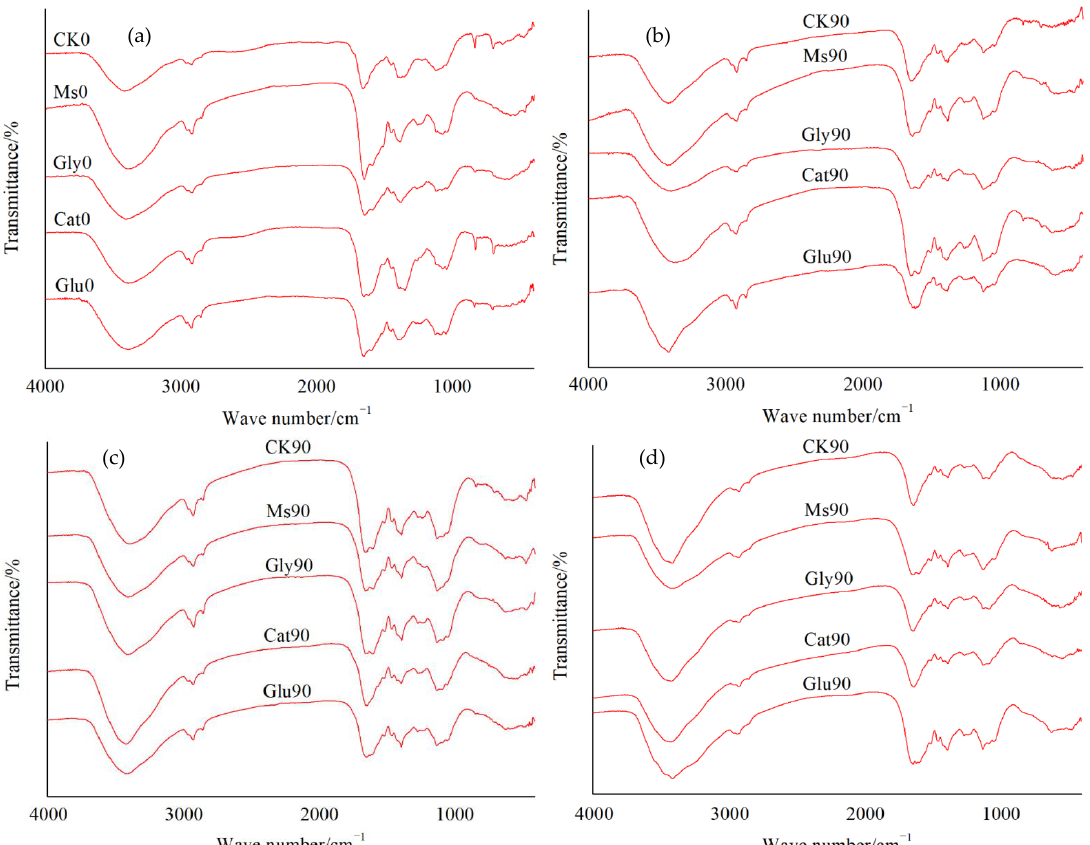
Figure 3. FTIR spectra of HLA extracted from the decomposing material of rice straw at different incubation temperatures: ( a ) 0 days before the incubation; ( b ) incubated at 10 °C for 90 days; ( c ) incubated at 15 °C for 90 days; ( d ) incubated at 28 °C for 90 days.